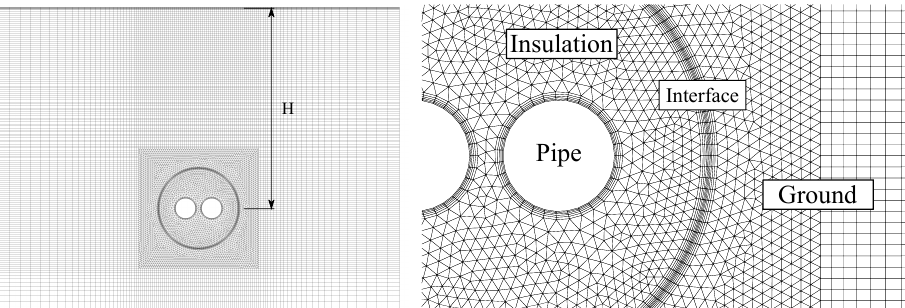
Figure 2. Sketch of the discretization grid: a mesh sample of the whole integration domain ( left ) and a close-up around the interface between the insulation and the surrounding ground ( right